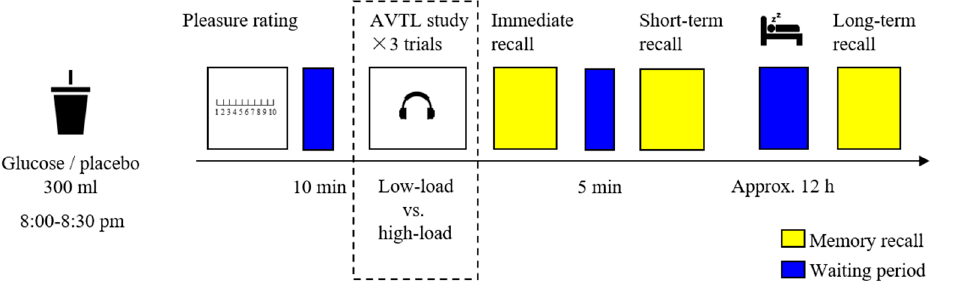
Figure 2. The experimental procedure. After consuming a drink of glucose or placebo, the older adults were administered both low- and high-load AVTL tasks. The immediate recall, short-term delayed recall, and long-term delayed recall were tested at different time